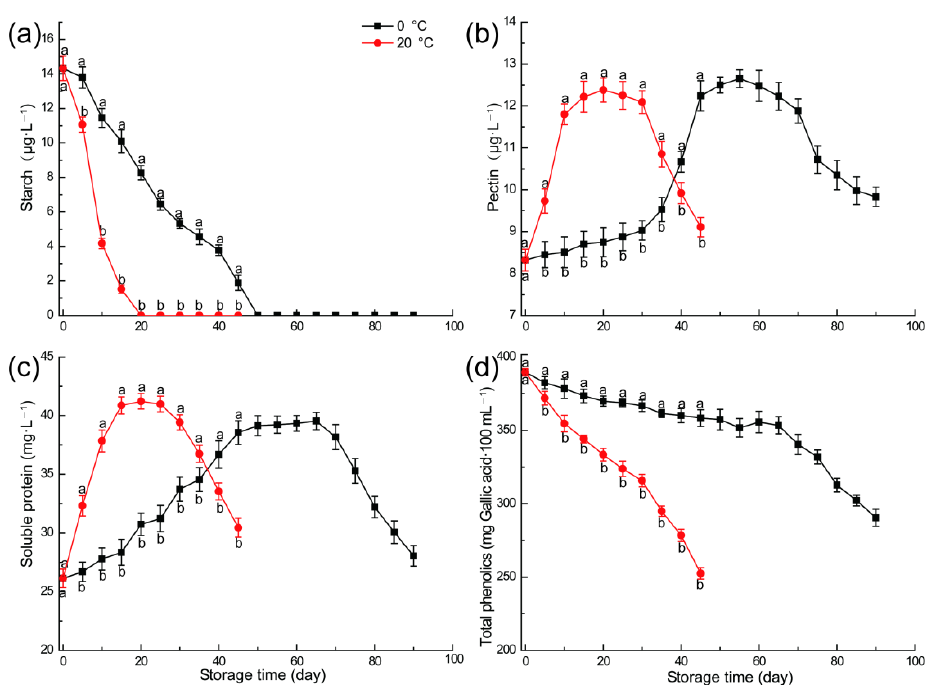
Figure 5. The concentration of starch ( a ), pectin ( b ), soluble protein ( c ), and total phenolics ( d ) in NFC apple juice from fruit under different temperatures and times. Vertical bars indicate ± standard errors of the mean values ( n = 3). Different letters represent significant differences among different treatment for each sampling time at p < 0.05.